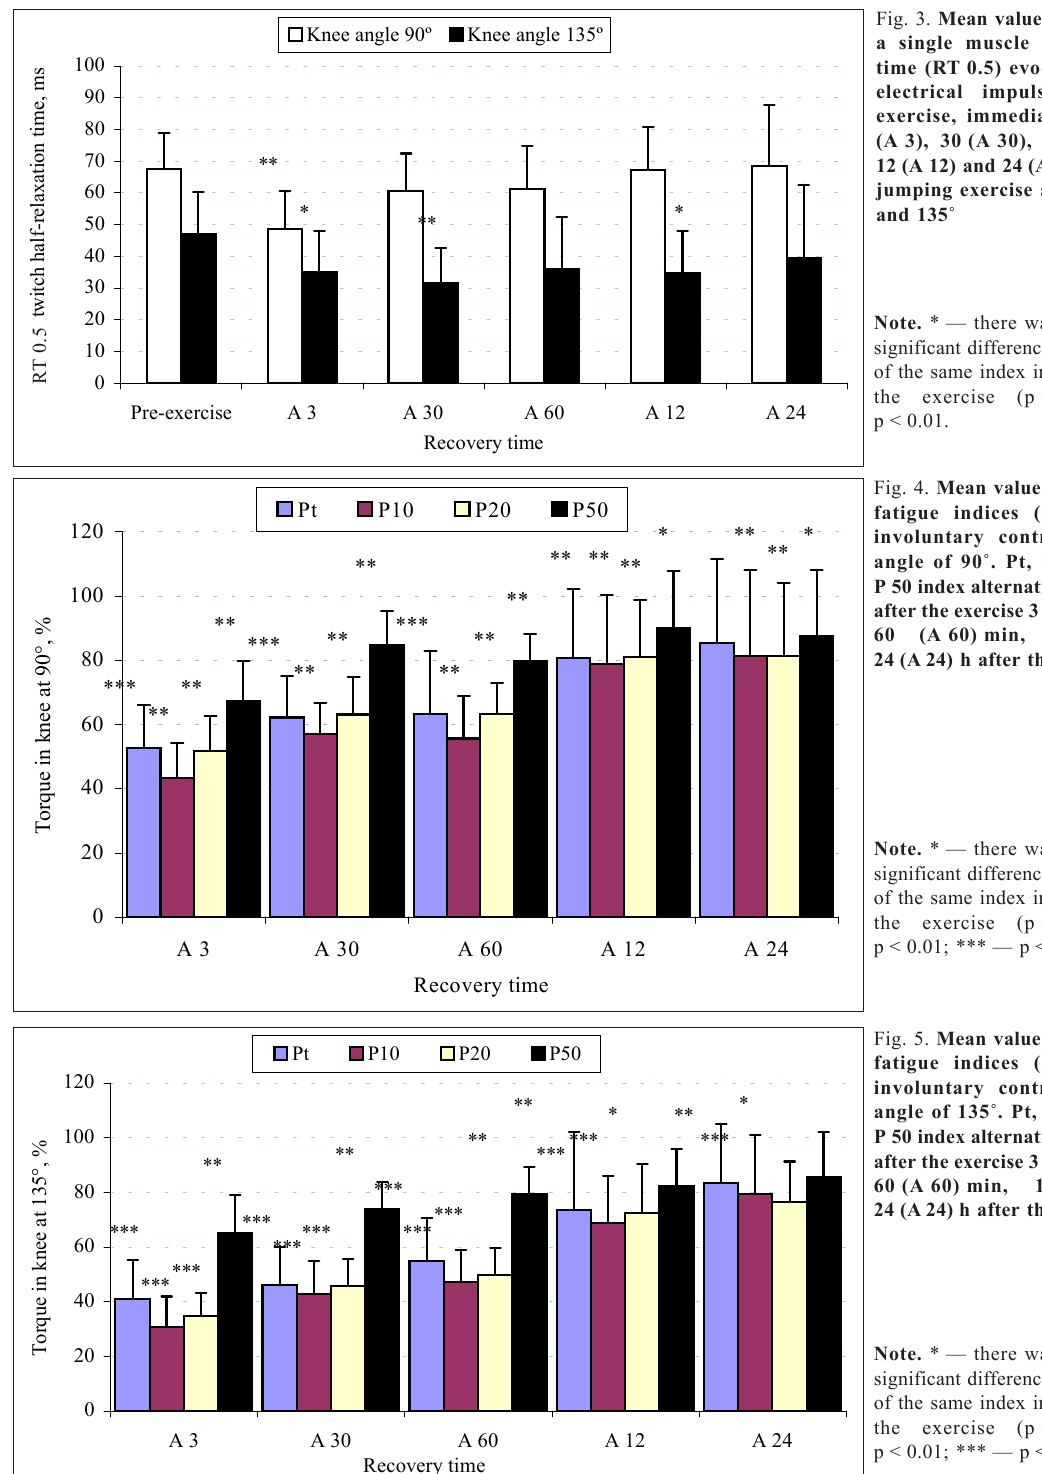
Fig. 5. Mean values of duration of fatigue indices (FI) of muscle involuntary contraction at the angle of 135 ˚ . Pt, P 10, P 20